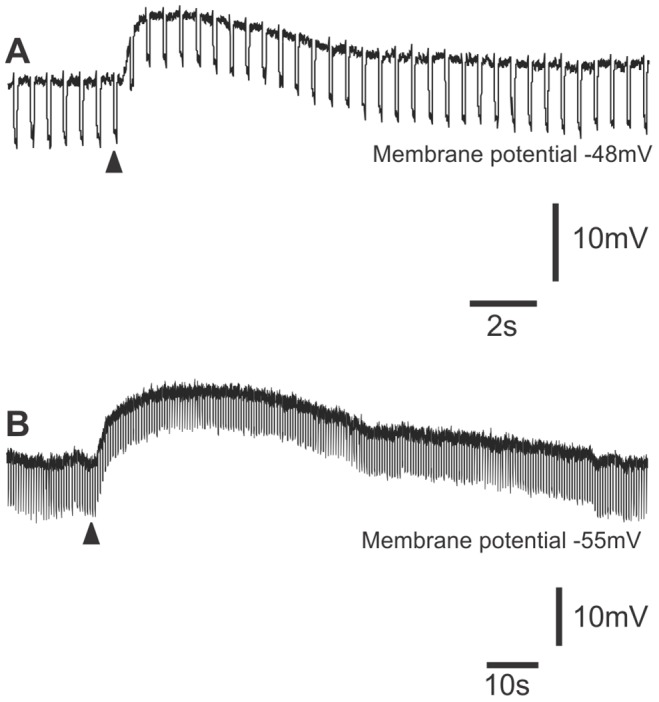
Effects of local application of ATP to myenteric S neurons.A. Application of ATP (arrowhead) evoked a rapid depolarization with a prominent decline in the membrane potential change evoked by hyperpolarizing current pulses, i.e. an increase in membrane conductance. B. Application of ATP (arrowhead) evoked a prolonged depolarization with no apparent change in membrane conductance in a distension-responsive neuron. Note the different time bases.